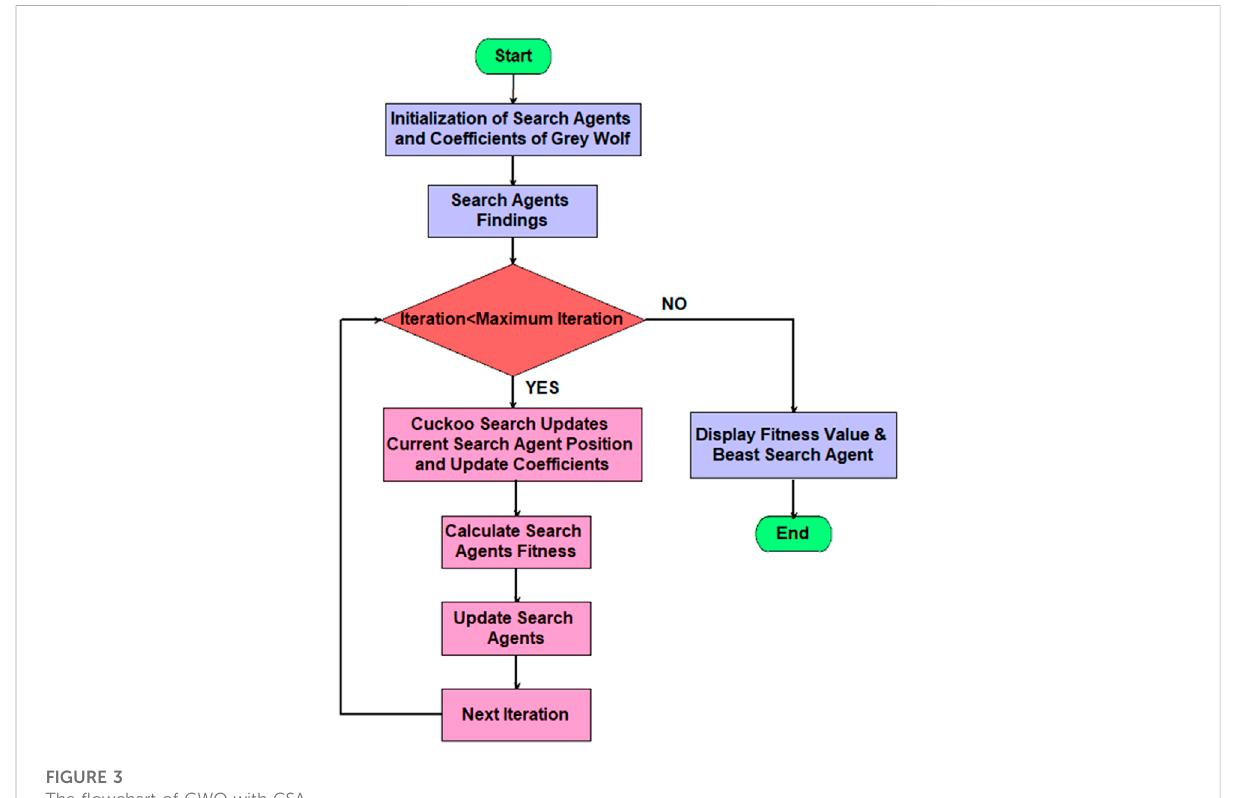
FIGURE 3 The fl owchart of GWO with